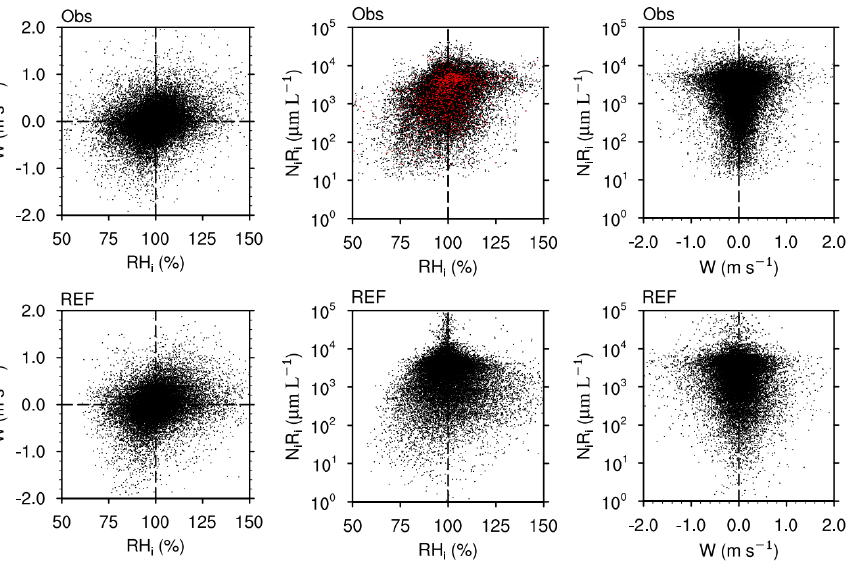
Figure 3. The scatter plots of W, RH i , and N i R i from observations ( upper panel ) and the REF experiment ( lower panel ). The dotted lines indicate RH i = 100% or W = 0 m s − 1 . Note that the 1000 samples selected for parcel model simulations are marked by red dots.